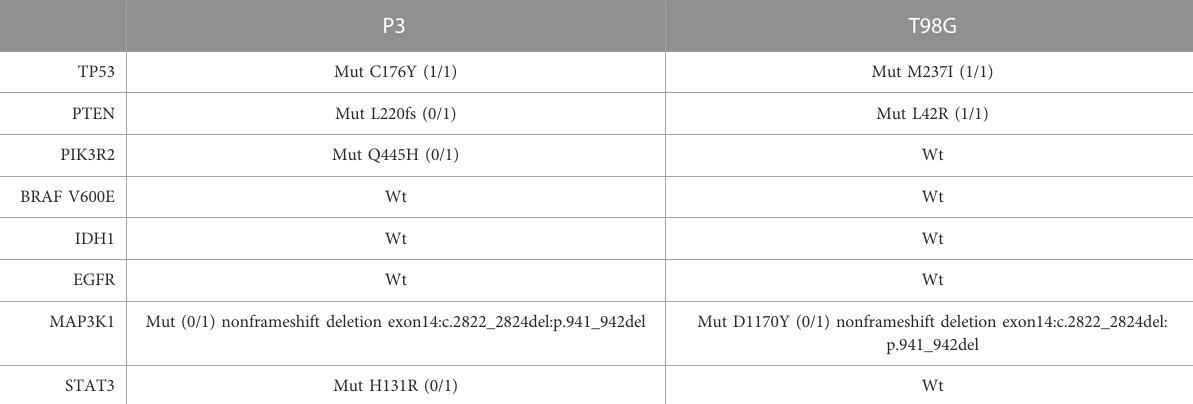
TABLE 1 Genetic background of GBM cell